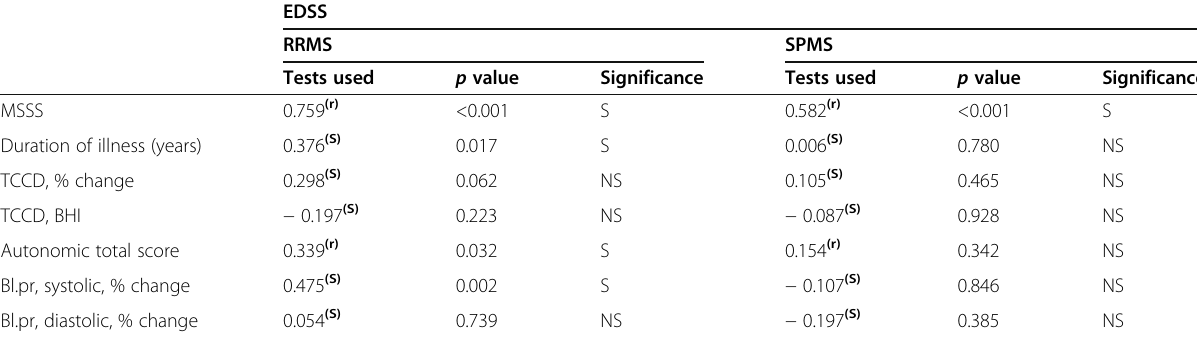
Table 1 Correlation between EDSS and TCCD, autonomic functions, blood pressure, and MSSS in both case groups